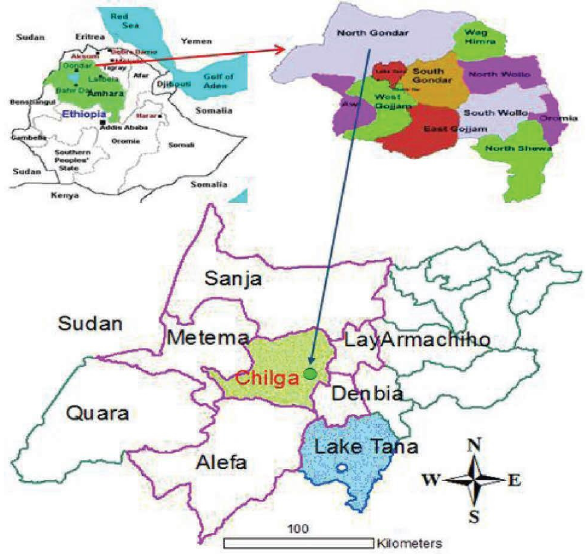
Figure 1: Map of the study area and its borders [11]. Table 1: Number of respondents in respective PAs and